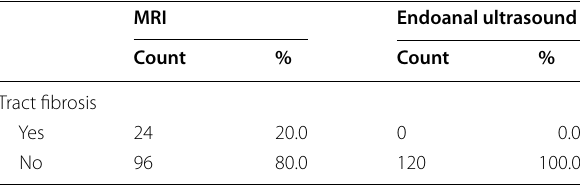
Table 6 Showing difference between MRI and endoanal ultrasound in the characterization of the fibrotic